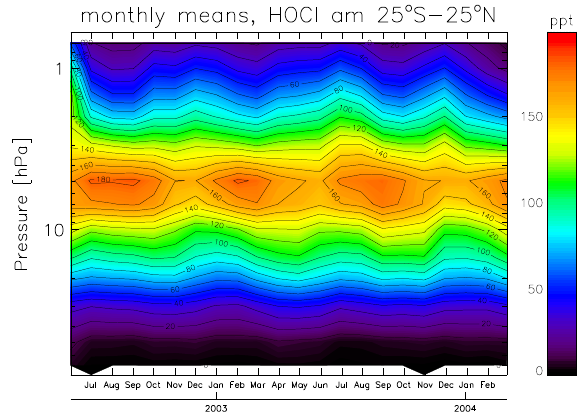
Fig. 5. Timeseries of HOCl zonal mean molar mixing ratios for the equatorial region 25 ◦ S–25 ◦ N. Measurements of the descending part of the orbit (10:00a.m.) are shown.